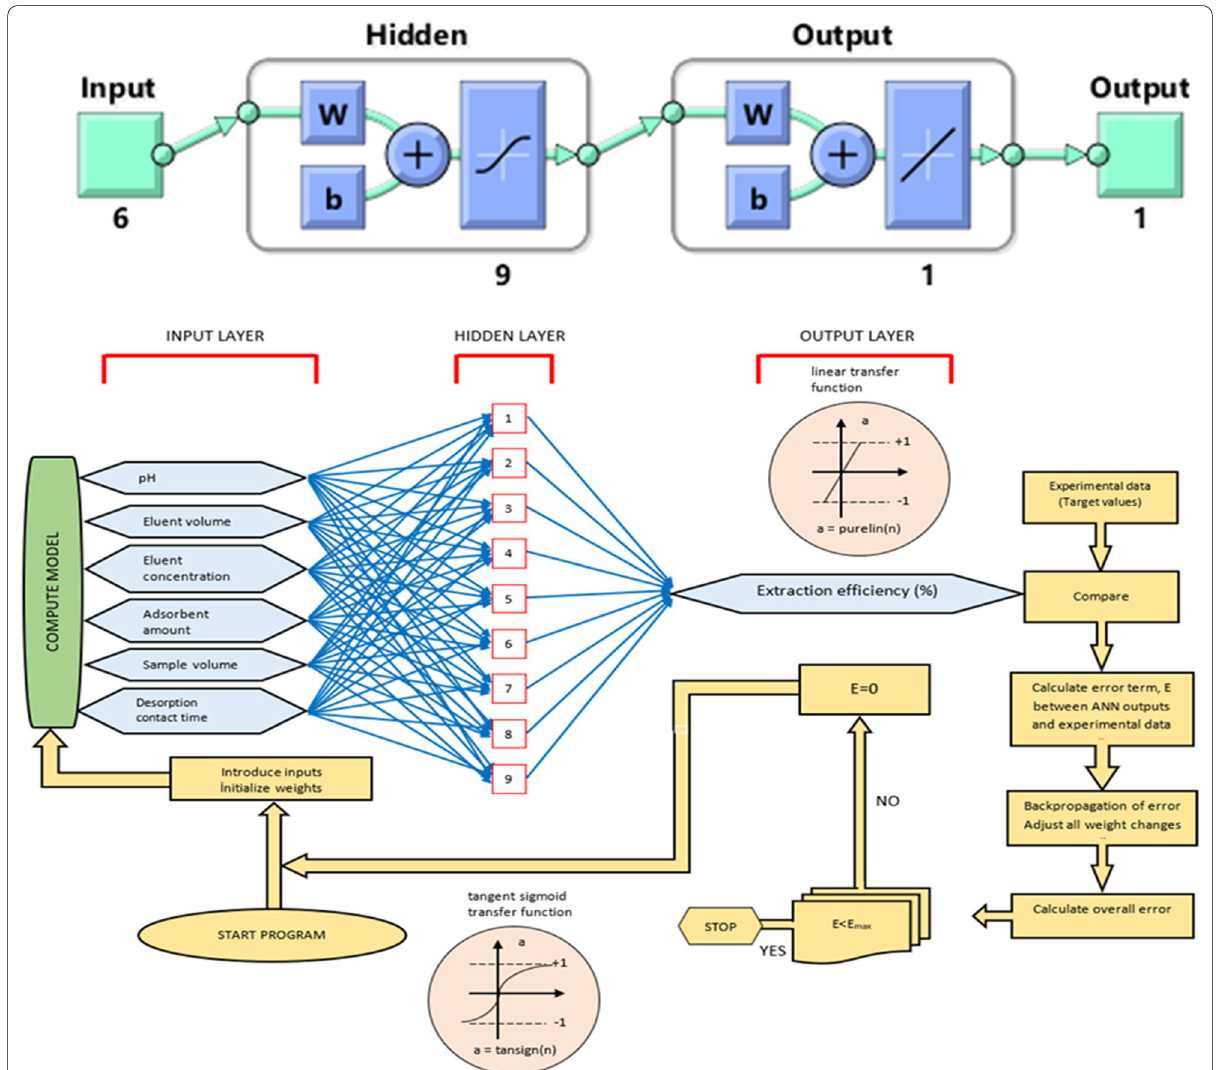
Fig. 1 ANN structure with a flowchart of the BP algorithm for the prediction of extraction